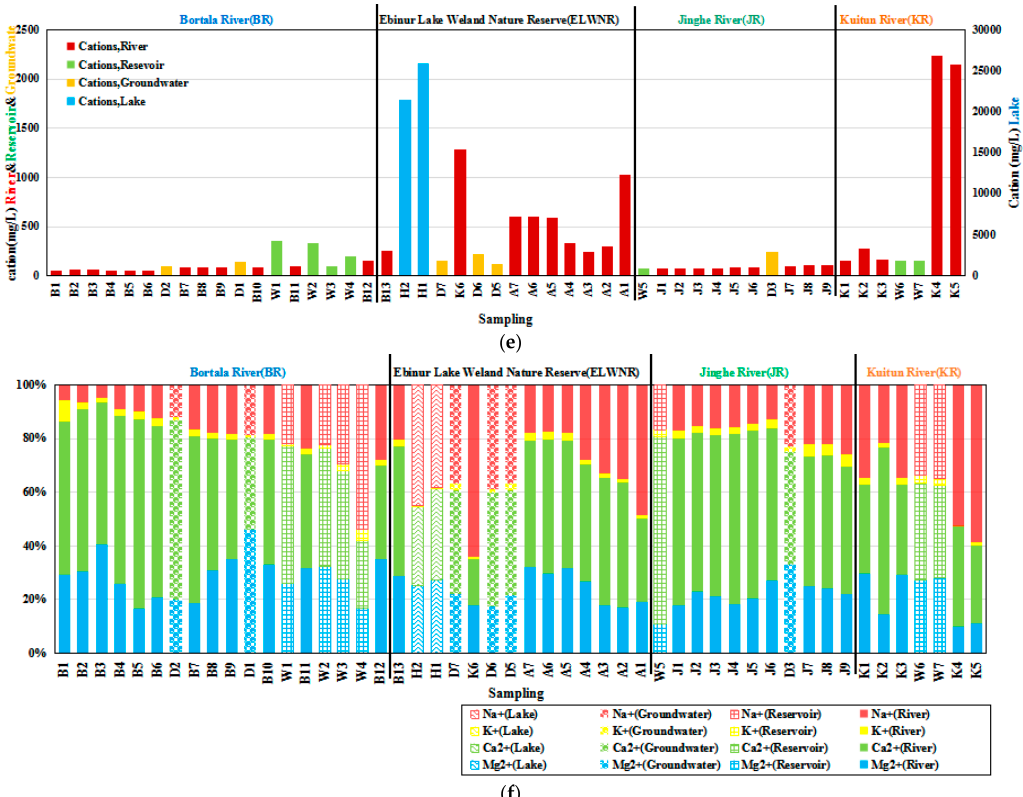
Figure 4. The spatial distribution of pH ( a ), total dissolved solids (TDS) ( b ), anions ( c , d ), and cations ( e , f ) in different water samples.